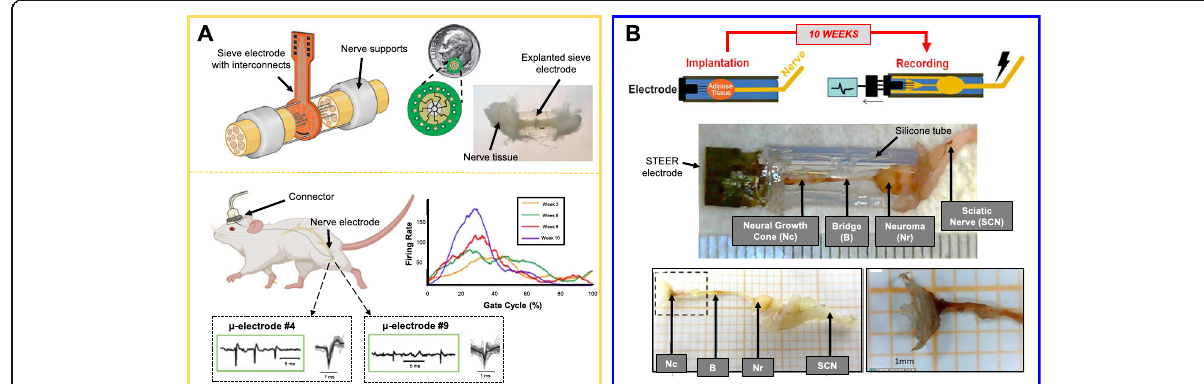
Fig. 3 Regenerative Nerve Interfaces. a Sieve electrodes are structured as porous disks, allowing a cut nerve ending to travel through the channels with electrode contacts after nerve-nerve coaptation surgery. Single unit action potentials have been evaluated during sciatic nerve regeneration in rats, showing that neuron firing rates increased over the course of 10 weeks (Musick et al., 2015). At the top is an illustration of a sieve electrode with interconnects for ENG recording as well as an image of an explanted that sieve electrode that was previously implanted in an animal (Freudenrich, 2007). At the bottom is a demonstration of how longitudinal ENG recordings can be taken from rodents via a head- mounted connector while walking. b The STEER electrode is a neuroma interface, designed to limit neuroma growth to within a 150 mm long silicone chamber (top) (Lahiri et al., 2016). Ten weeks after the sciatic nerve of 5 rats was cut and implanted into the STEER electrode, a neuroma had formed (middle). The neuroma was only a few millimeters long, and some unexpected neuro-fibrous tissue structures were found to grow within the rest of the silicone tube (middle and bottom). At the very end of the chamber, a neural growth cone formed over the electrode wires, and the tissue produced electrically-evoked compound APs of a few hundred microvolts. Future STEER electrodes can have more detail for the purpose of guiding the neural growth cone towards making more contacts with the electrode sensor (Blasiak et al.,